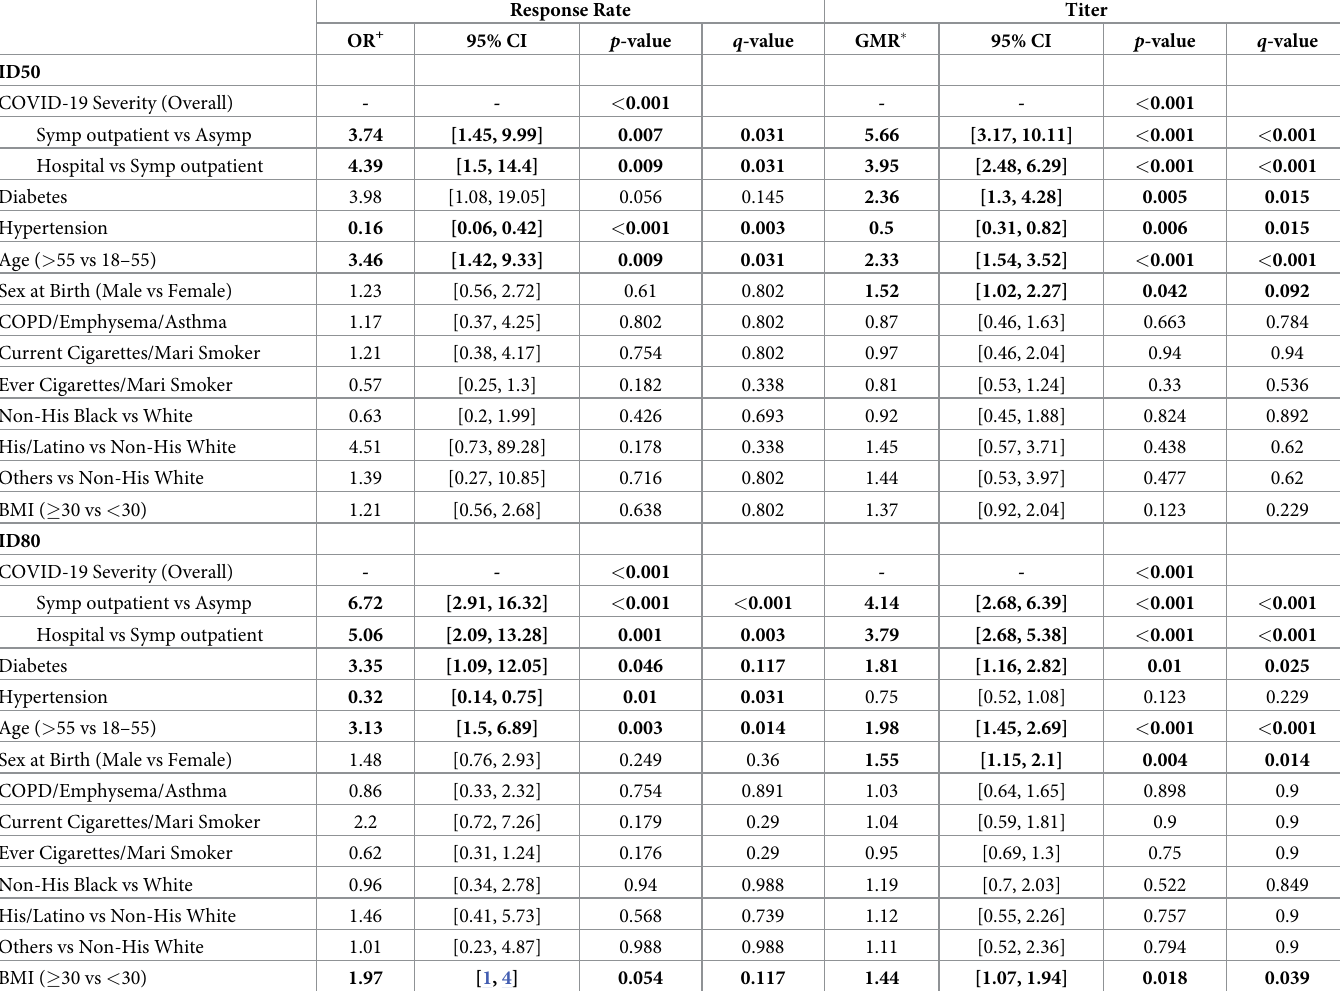
Table 2. Associations of COVID-19 severity, medical history, demographics, and days since SARS-CoV-2 diagnosis with nAb responses among the convalescent participants in Americas ( n = 329). Response Rate